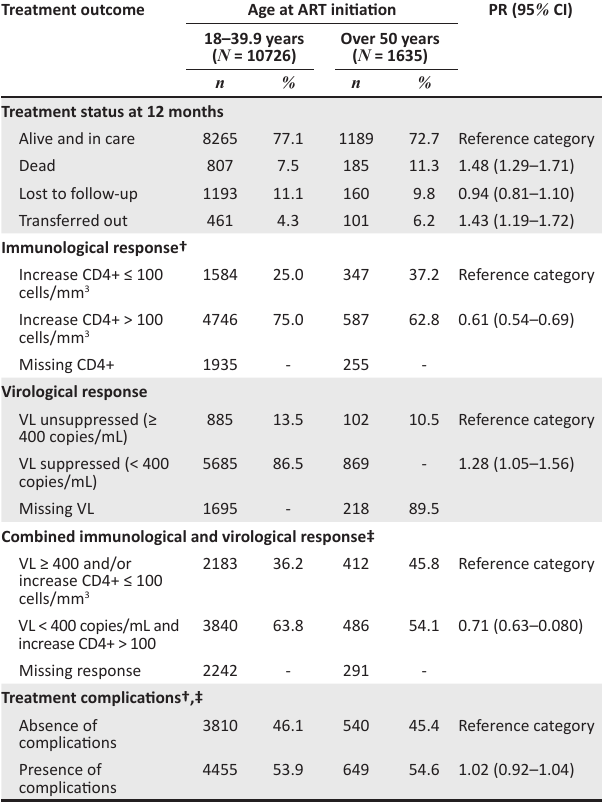
TABLE 2: Treatment status, immunological and virological response and treatment complications outcomes after 12 months of antiretroviral therapy by age at antiretroviral therapy